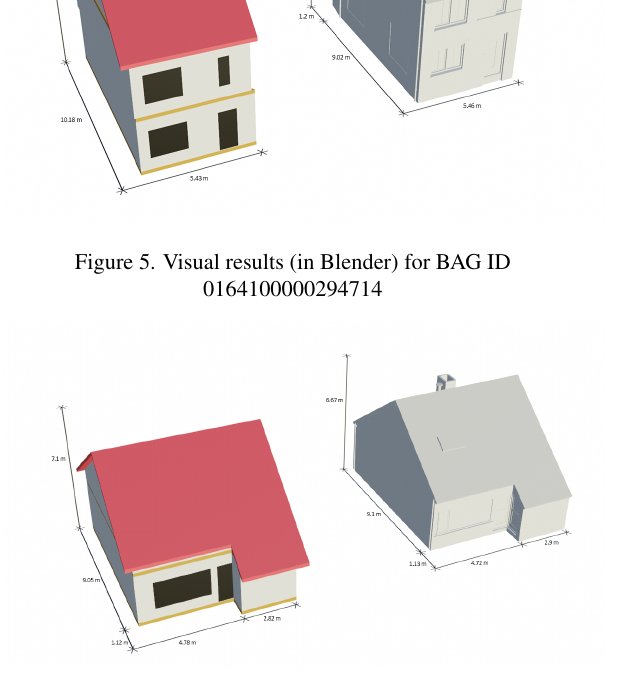
Figure 6. Visual results (in Blender) for BAG ID